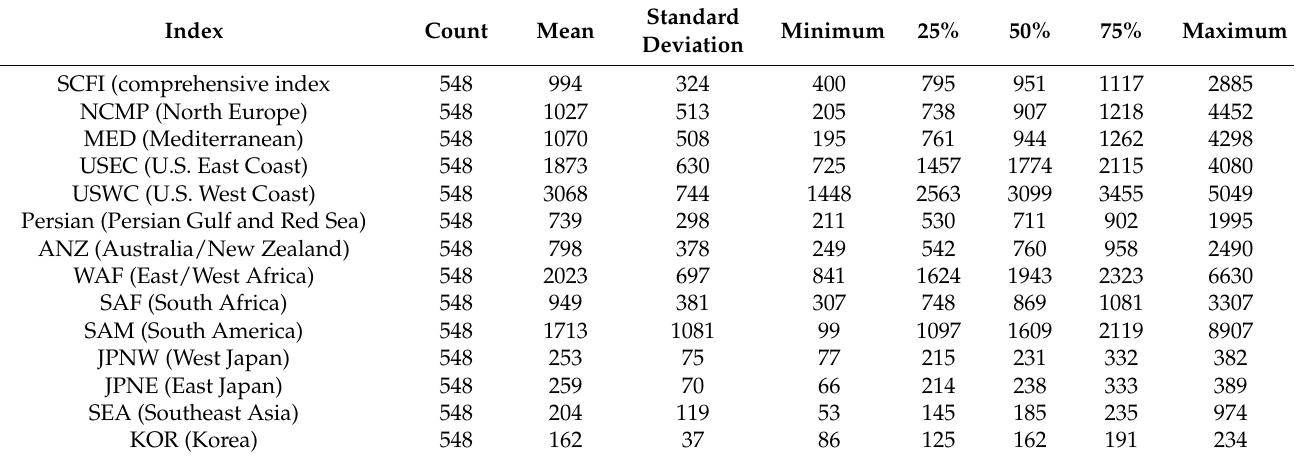
Table 2. Description of